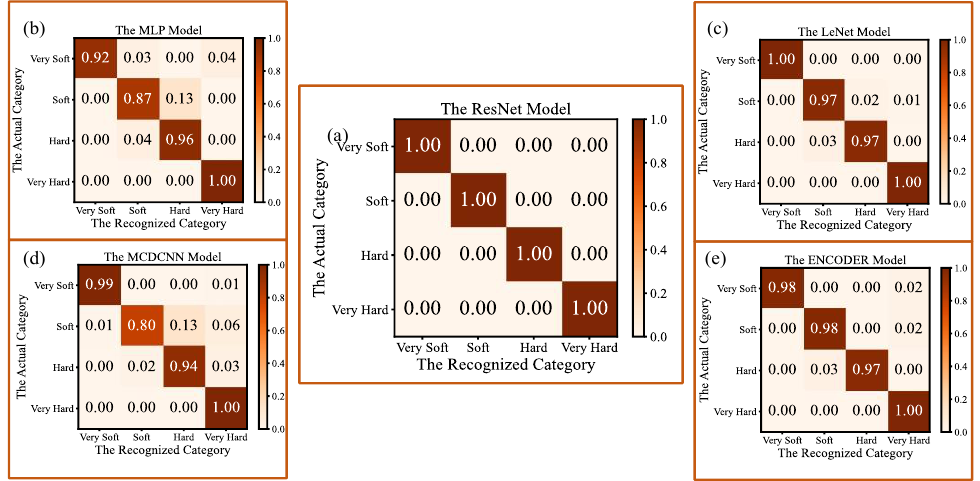
Figure 12. Confusion matrixes of recognition results for the four-hardness categories based on the five models: ( a ) The confusion matrix for the ResNet model; ( b ) The confusion matrix for the MLP model; ( c ) The confusion matrix for the LeNet model; ( d ) The confusion matrix for the MCDCNN model; ( e ) The confusion matrix for the ENCODER model.